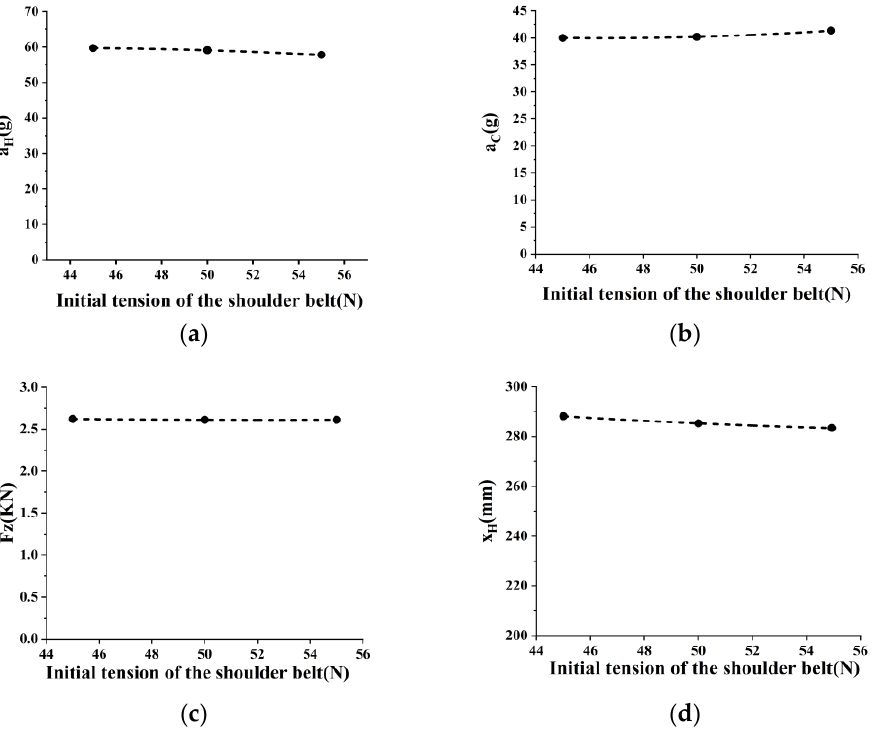
Figure 12. A value of 3 ms head resultant acceleration 𝑎 𝐻 variation ( a ); 3 ms chest resultant accel- eration 𝑎 𝐶 variation ( b ); upper neck tension 𝐹 𝑍 variation ( c ); the head horizontal displacement 𝑥 𝐻 variation ( d ) caused by the shoulder belt initial tension adjustment.